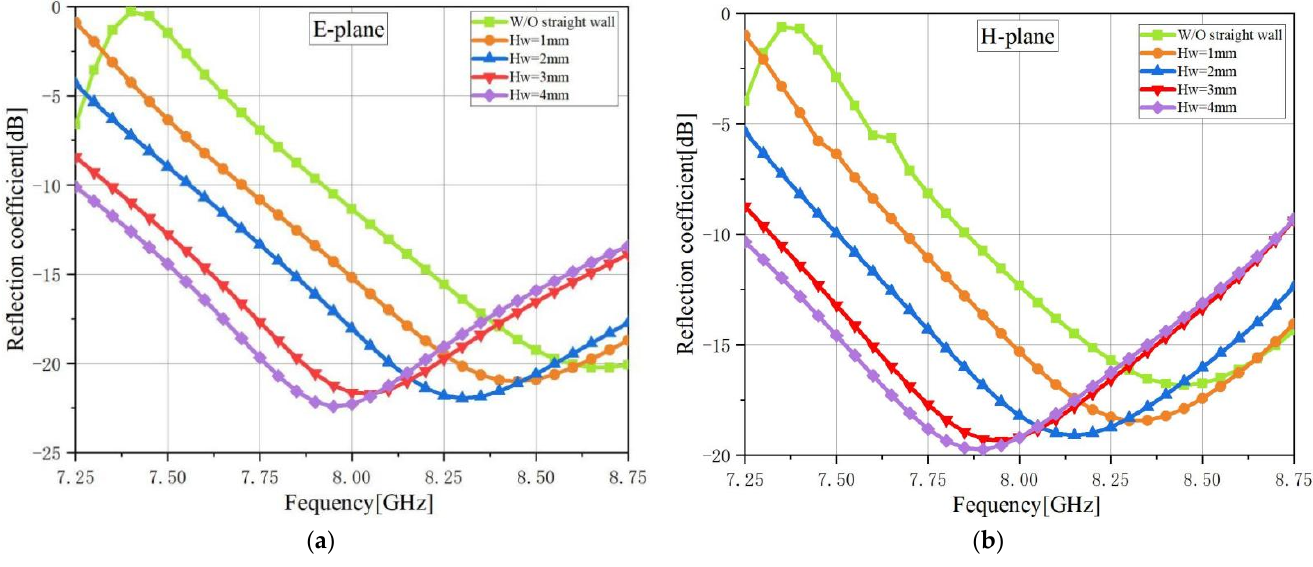
Figure 3. The comparison of the active S 11 before and after loading the metal sidewall when the scan angle is ±10°: ( a ) E ‐ plane and ( b ) H ‐